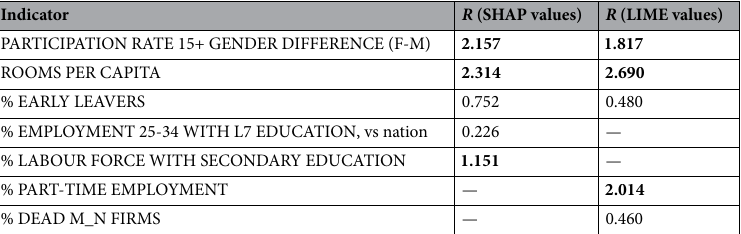
Table 1. Resolution ratios R of the SHAP (LIME) distributions with respect to the partition of TL2 subregions in network communities, associated to the top-5 indicators in terms of mean absolute SHAP (LIME) values. Resolution ratios larger than 1, highlighted in boldface, indicate an average tendency of distributions pertaining to different communities to separate from each other. Missing entries correspond to the distributions of indicators that do not rank among top-5 in terms of either SHAP or LIME mean absolute values.